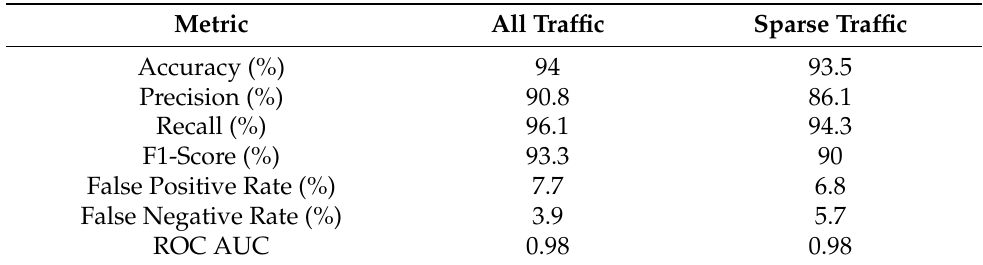
Table 3. LSTM-RF window detection